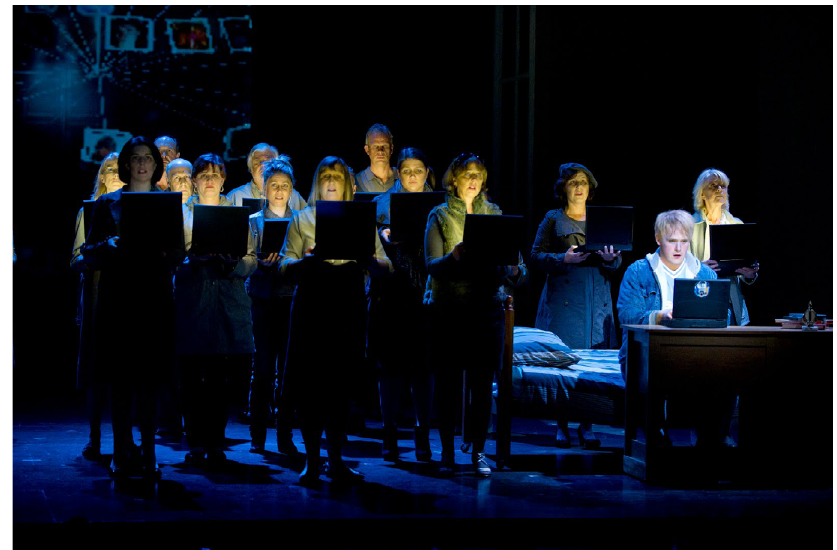
Fig. 1 – Nico Muhly, Two Boys , Metropolitan Opera. Photo credit: Richard Hubert